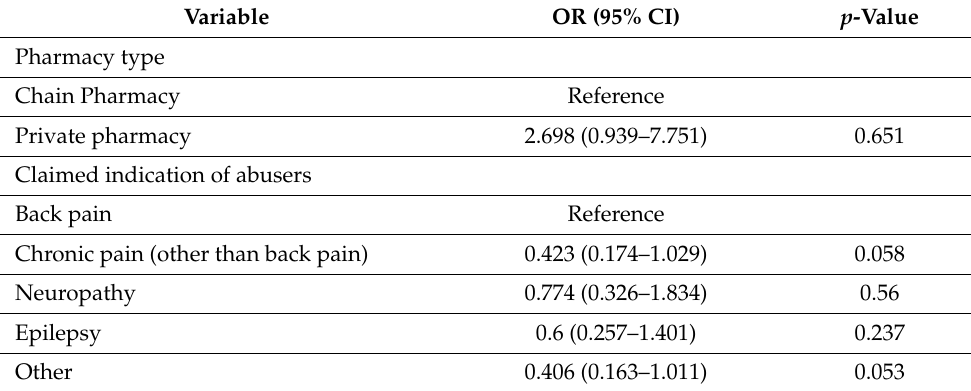
Table 4. Multiple logistic regression examining potential factors affecting the perceived change in pregabalin abuse during the last year (if OR is more than 1, this means that the misuse of pregabalin was increased in comparison to the last year).